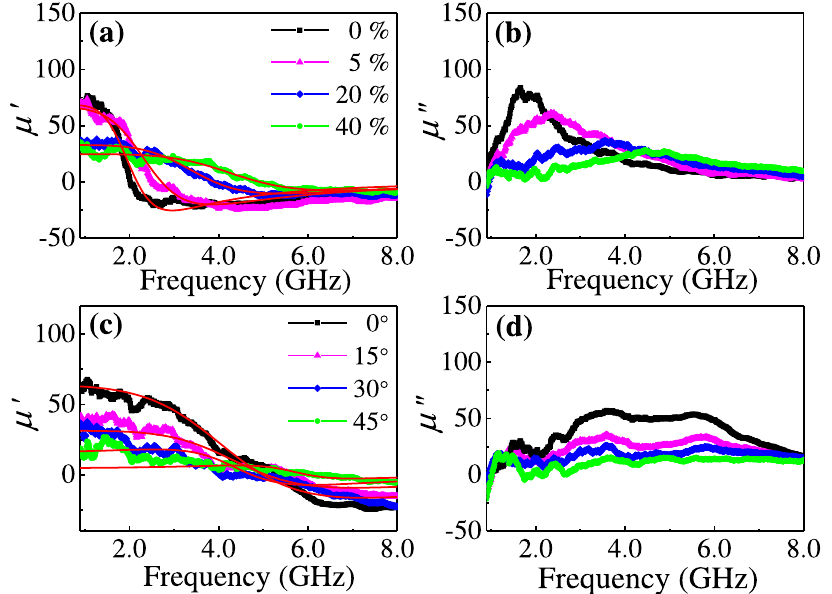
Figure 4. ( a ) Real and ( b ) imaginary permeability spectra obtained at zero bias field for FeCoTa films grown with different pre-strains. ( c ) Real and ( d ) imaginary permeability spectra obtained at zero bias field for FeCoTa films grown with different deposition angles. The red lines are the fitting by the LLG